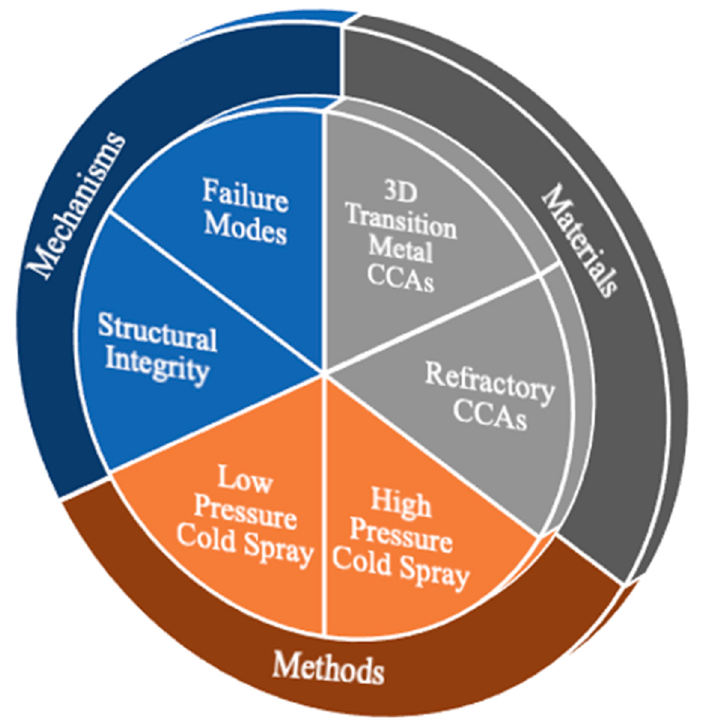
Figure 18. Future perspectives for cold sprayed CCA-based coatings for structural and functional applications.